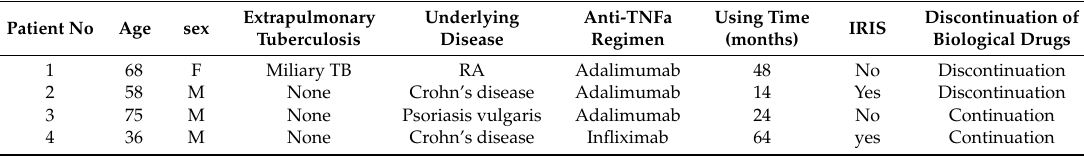
Table 6. Patient characteristics treated with anti-tumor necrosis factor- α